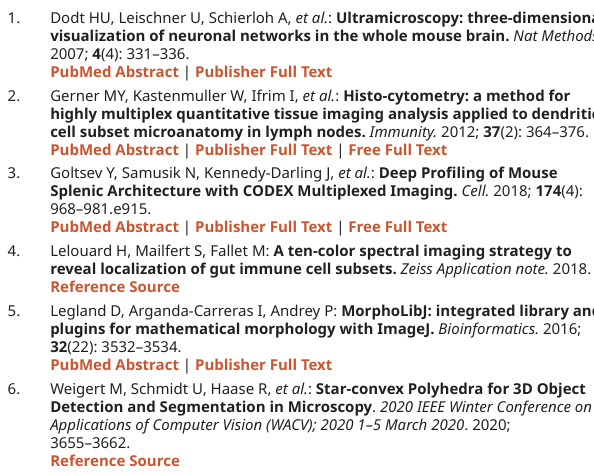
(Figure 6, lower left panel with selected cells boxed in red). In our case, no errors were detected but if they were, the anno- tation menu would have allowed to correct them.